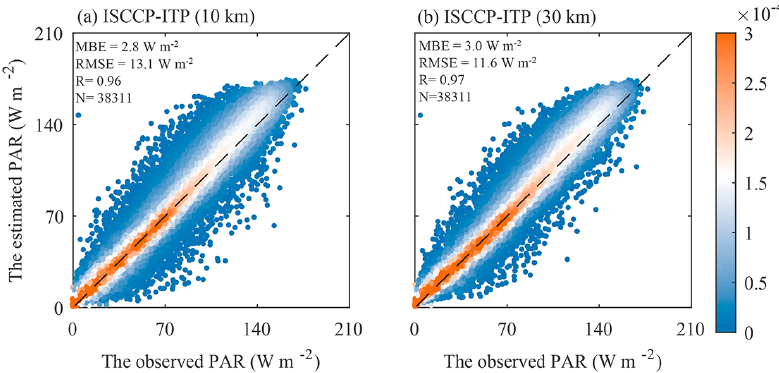
Figure 6. Comparisons of our estimated daily PAR product (ISCCP-ITP) at spatial resolutions of (a) 10km and (b) 30km with observed PAR collected at 42 NEON stations.